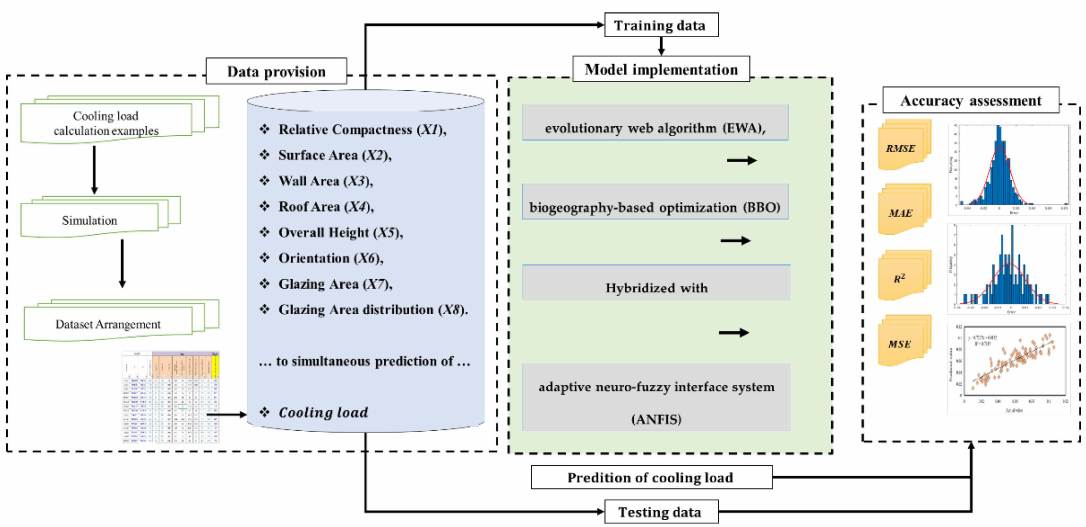
Figure 3. Proposed hybrid model